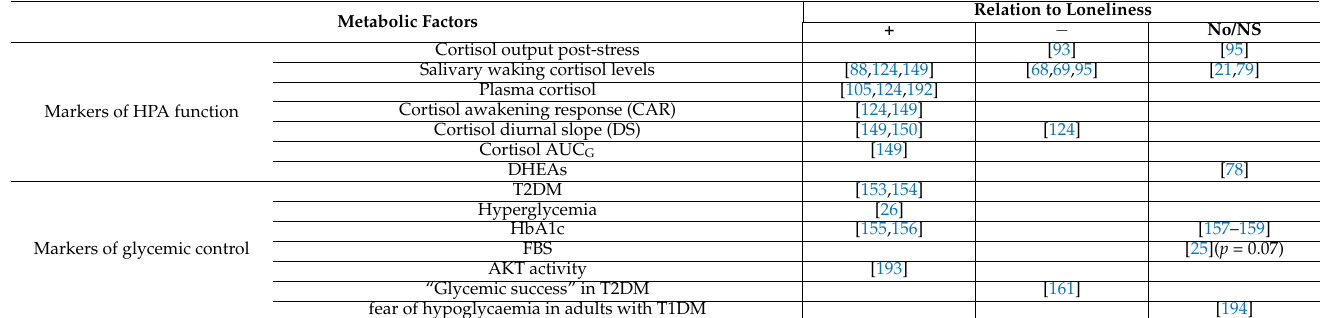
Table 3. An overview of metabolic factors investigated in relation to loneliness. Metabolic Factors Cortisol output Markers of HPA function